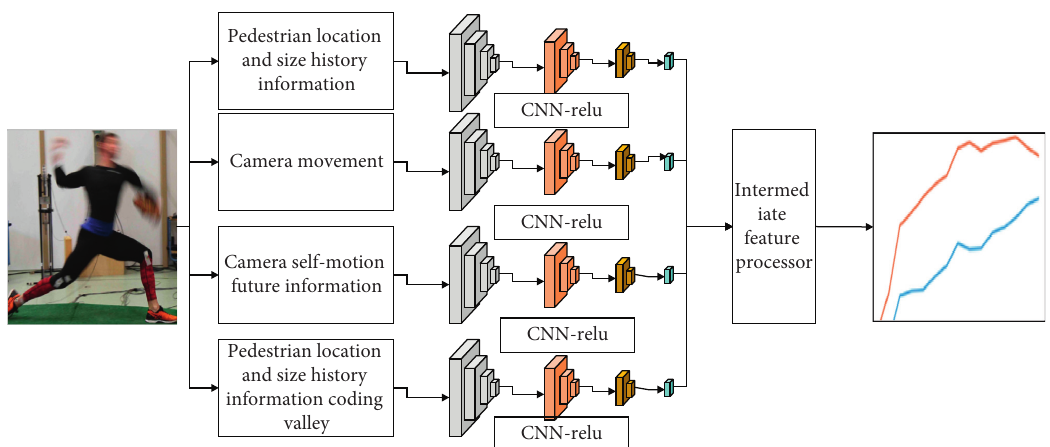
Figure 2: CNN-LSTM trajectory prediction